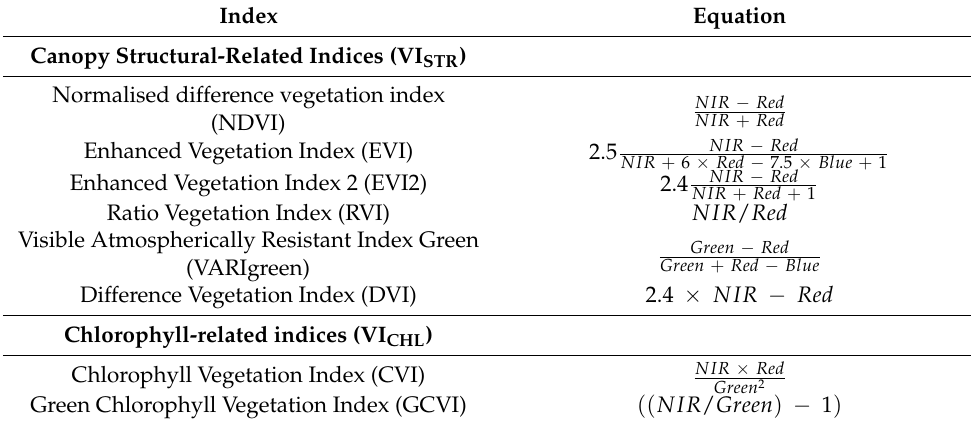
Table 2. Vegetation